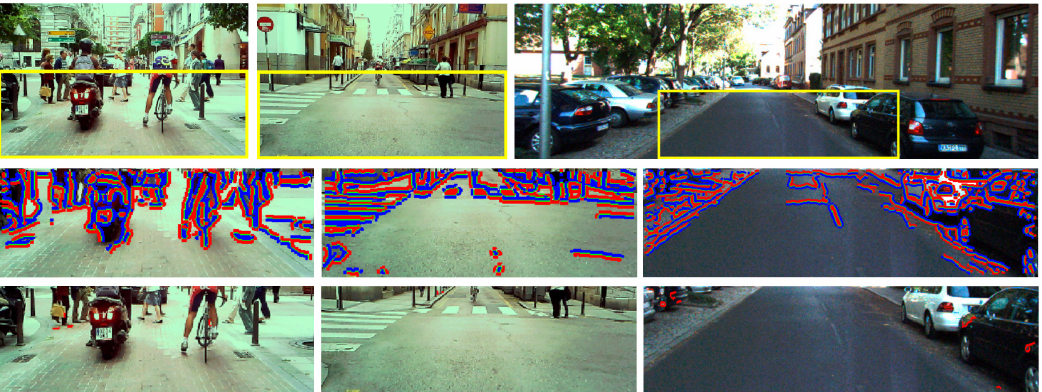
Figure 19. ( Row 1 ) input images; ( Row 2 ) ROI overlaid with brighter (red) and darker (blue) regions across strong edges (green); ( Row 3 ) results of the proposed shadow edge detection